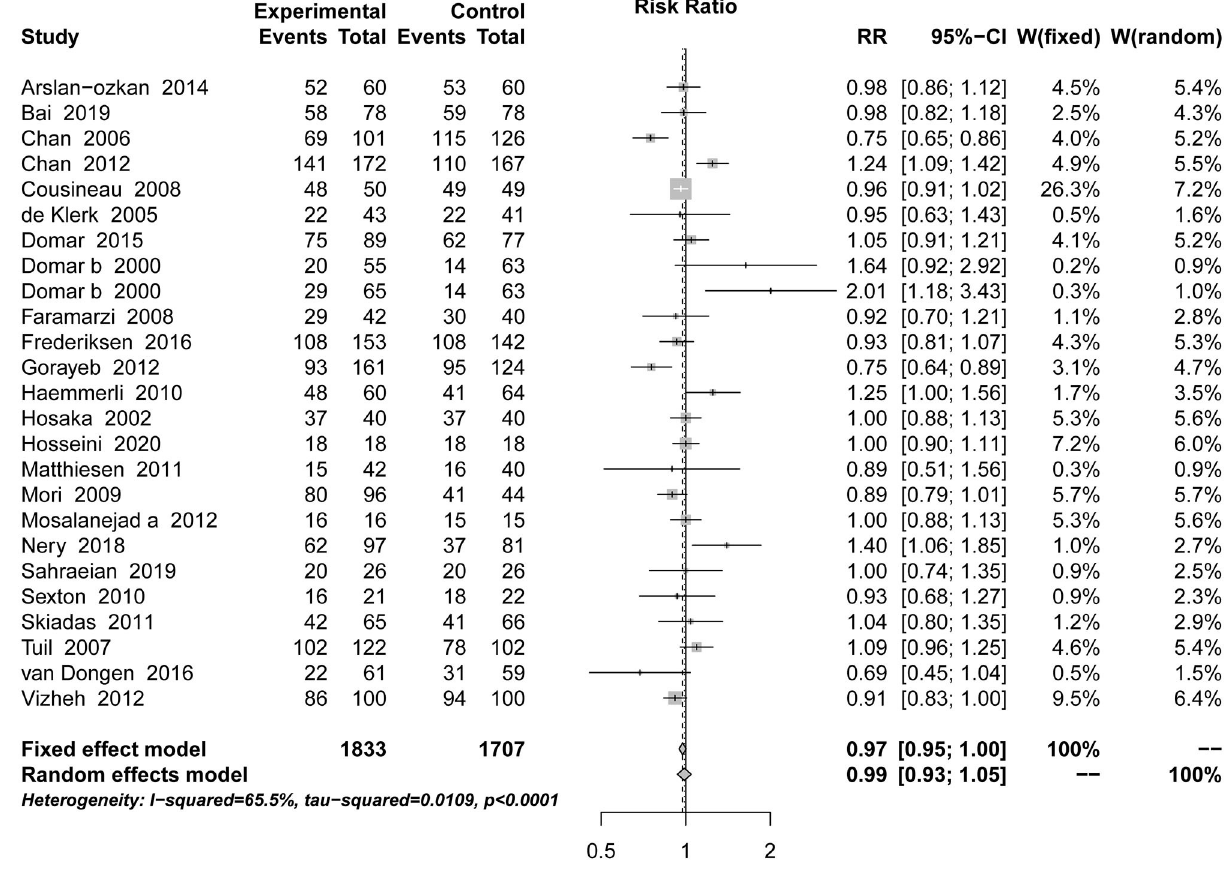
FIGURE 5 | Forest plot of